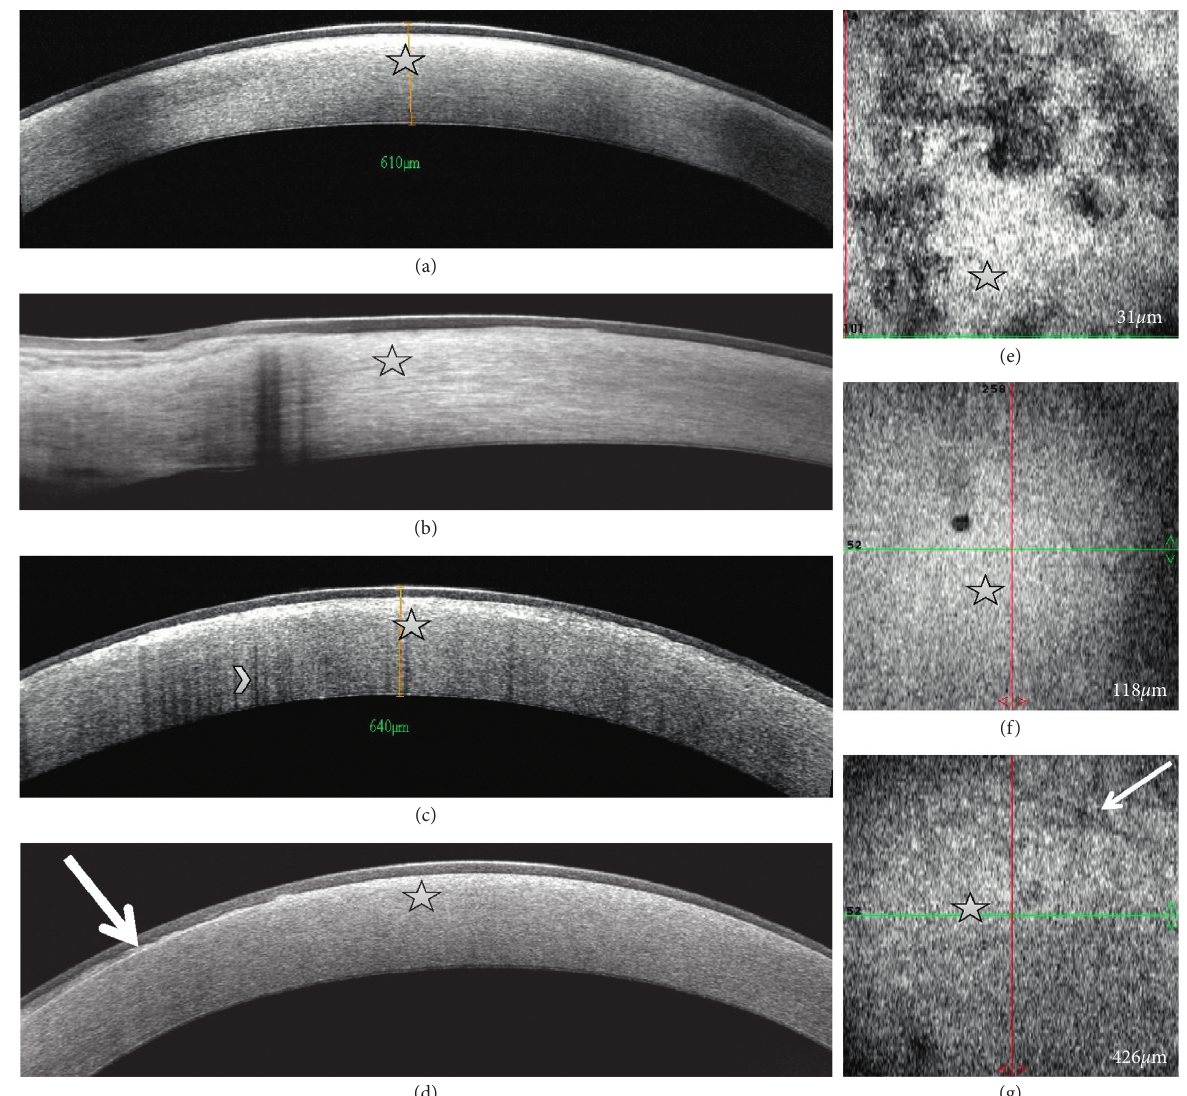
Figure 2: Cross-sectional and en face spectral domain-optical coherence tomography scans showing diffuse hyperreflective corneal stromal opacities (arrows), maximum in the anterior stroma and expanding to the limbus in eyes with Schnyder dystrophy. (a) Central diffuse stromal hyperreflectivity. (b) Limbal and peripheral corneal stromal hyperreflectivity. (c) Diffuse optical shadow from the stromal side (arrowhead; patient #7). (d) Thick hyperreflective corneal epithelial basement membrane insinuating into the epithelium (thick arrow) (patient #5). En face scans reveal epithelial (e), anterior stromal (f), and posterior stromal (g) hyperreflectivity. Stromal striae are visible in the posterior stroma (thin